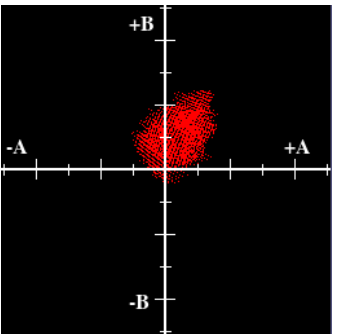
Figure 17. The L*a*b* color space look-up table used for negative classification of plastic in a cotton gin-stand detection system. The black pixels in the image show the colors defined as non-plastic and are thus ignored. Should a color in a processing image land outside of the black pixel coordinates, the pixels are classified as plastic.